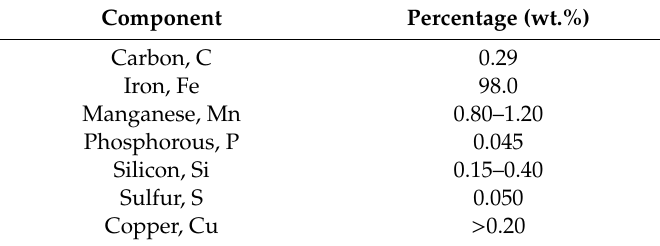
Table 4. The chemical composition of A36 (low carbon steel).